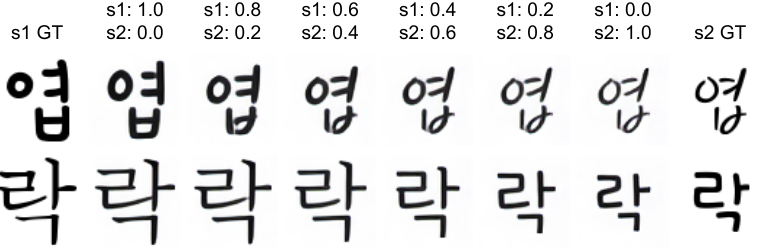
Figure 10. Examples of style interpolation between two unseen font styles. The first row represents interpolation weights for two